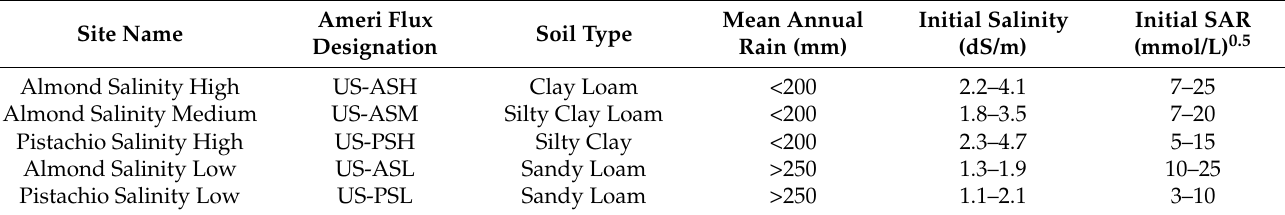
Table 1. List of study orchards and their characteristics.